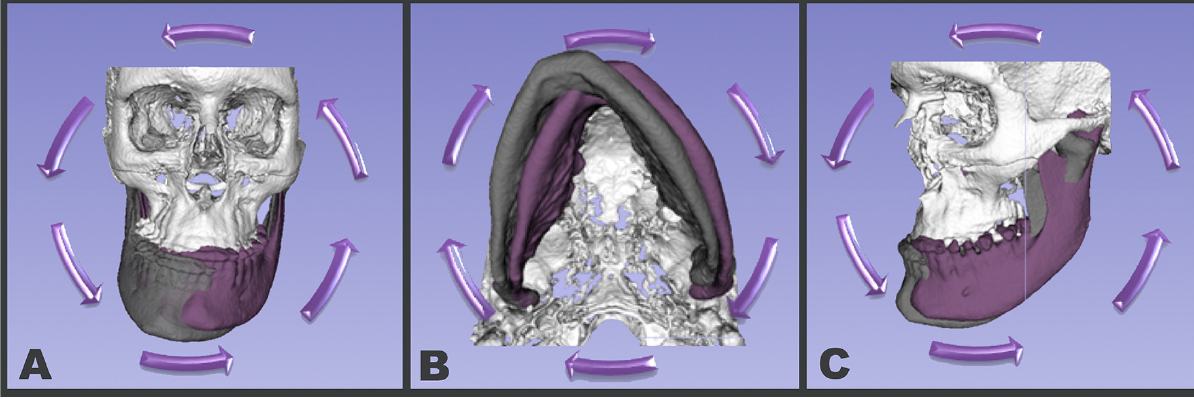
Figure 4- Schematic illustration of roll, yaw and